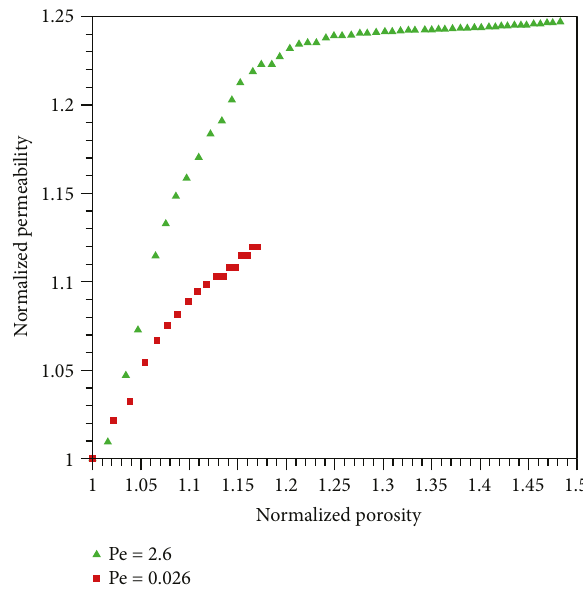
Figure 19: E ffl uent Ca concentrations versus time at two di ff erent Pe numbers.